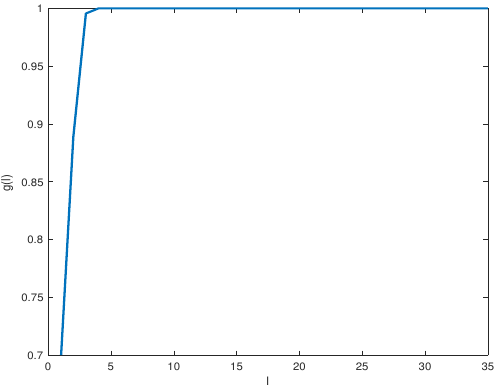
Figure 5. Energy fraction captured by the top l singular